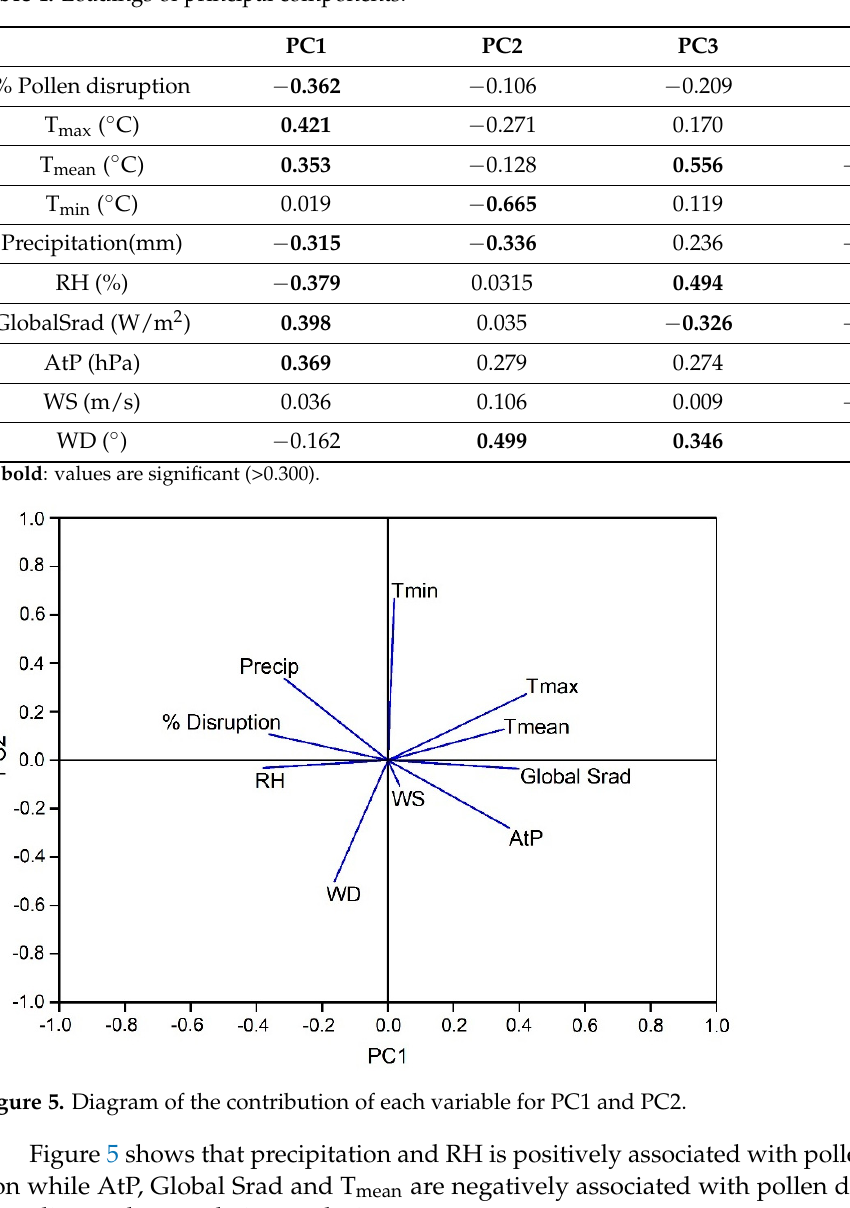
Table 4. Loadings of principal components.